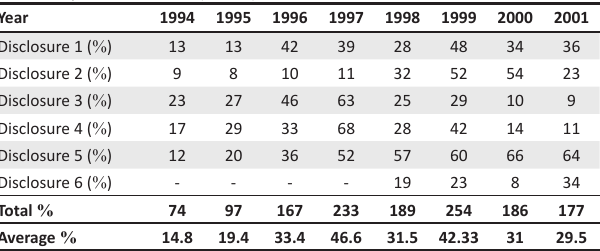
TABLE 3a: Analysis on corporate environmental disclosure in the mining sector based on previous studies (case 1).